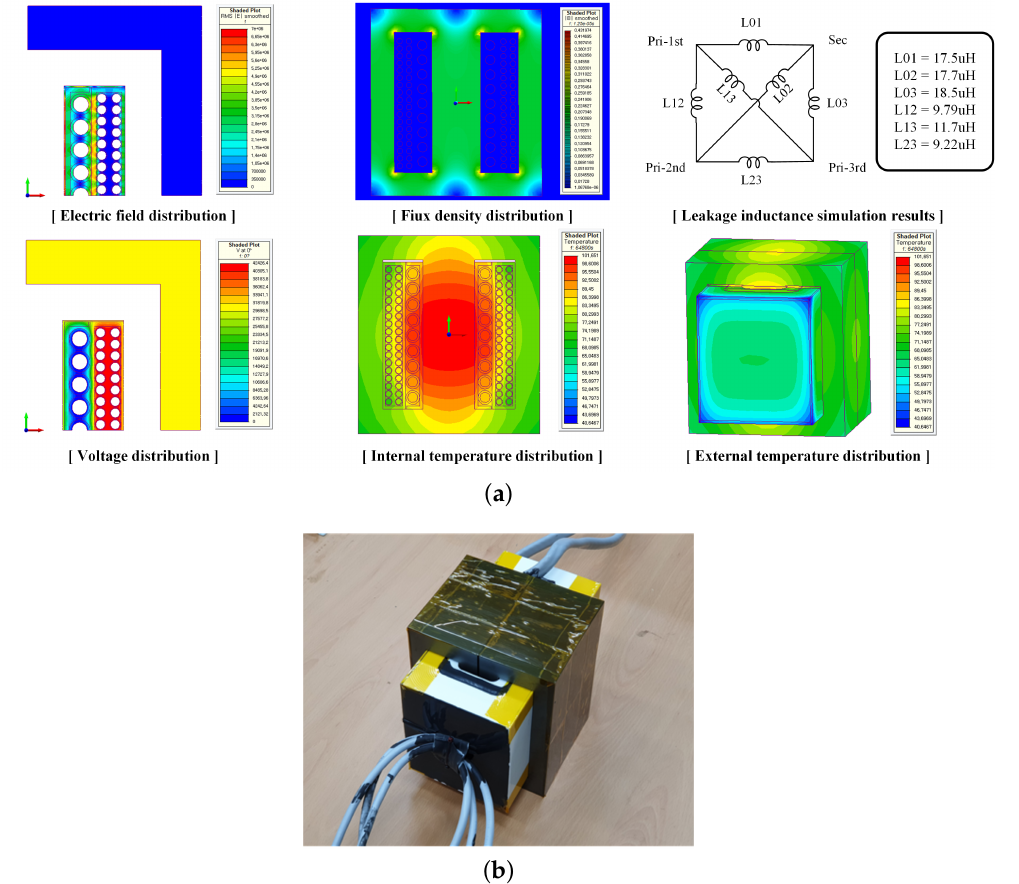
Figure 4. The proposed high-frequency isolation transformer of QAB converter: ( a ) electric, magnetic, and thermal FEM simulation results; ( b ) prototype